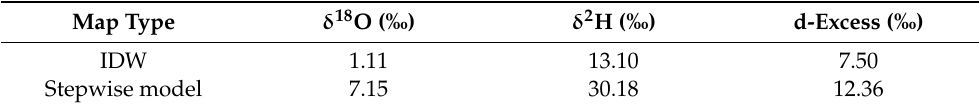
Table 1. The RMSE in the stable isotope distribution maps in precipitation across the Middle East.